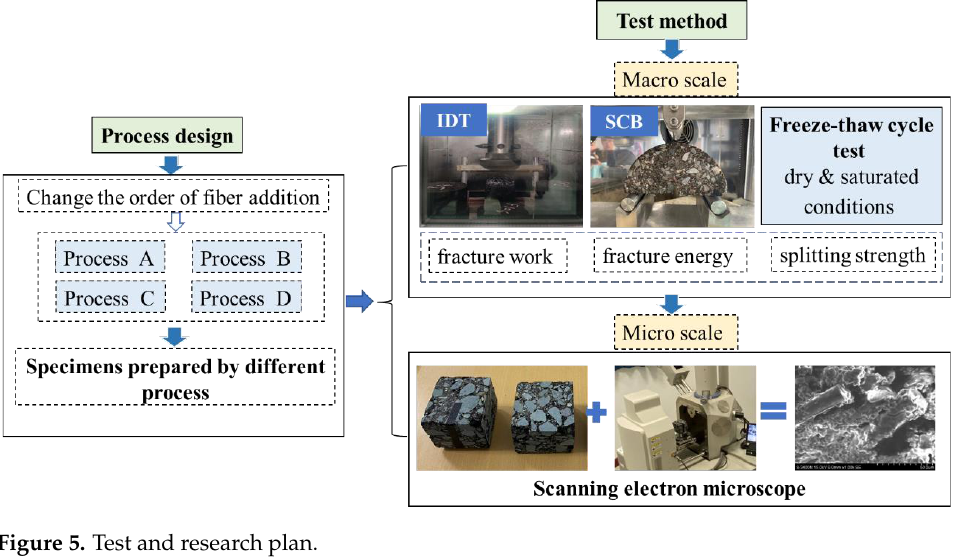
Figure 5. Test and research plan.